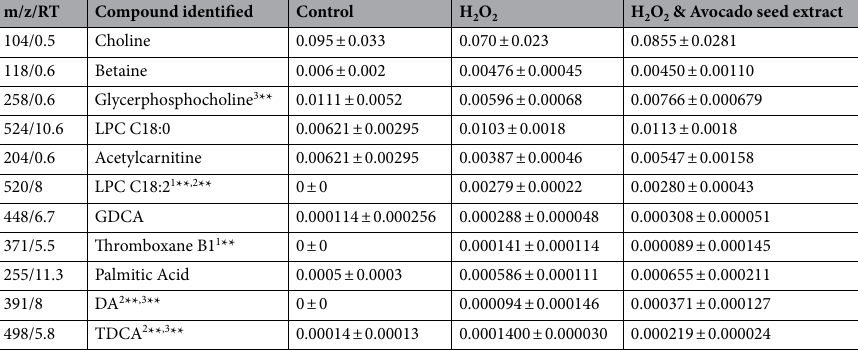
Table 2. Normalised peak areas of lipids and others present in HMEC-1 cells from control, H 2 O 2 , and H 2 O 2 and avocado seed extracts, Data is presented as mean ± SD, n = 6. RT: retention time. 1 Denotes significant different between the control group and the H 2 O 2 group. 2 Denotes significant different between the control group and H 2 O 2 and avocado seed extract treatment group. 3 Denotes significant different between the H 2 O 2 group and H 2 O 2 and avocado seed extract treatment group. *Denotes a p value of less than 0.05, ** denotes a p value of less than 0.01, 1-way ANOVA, Tukey’s post-hoc